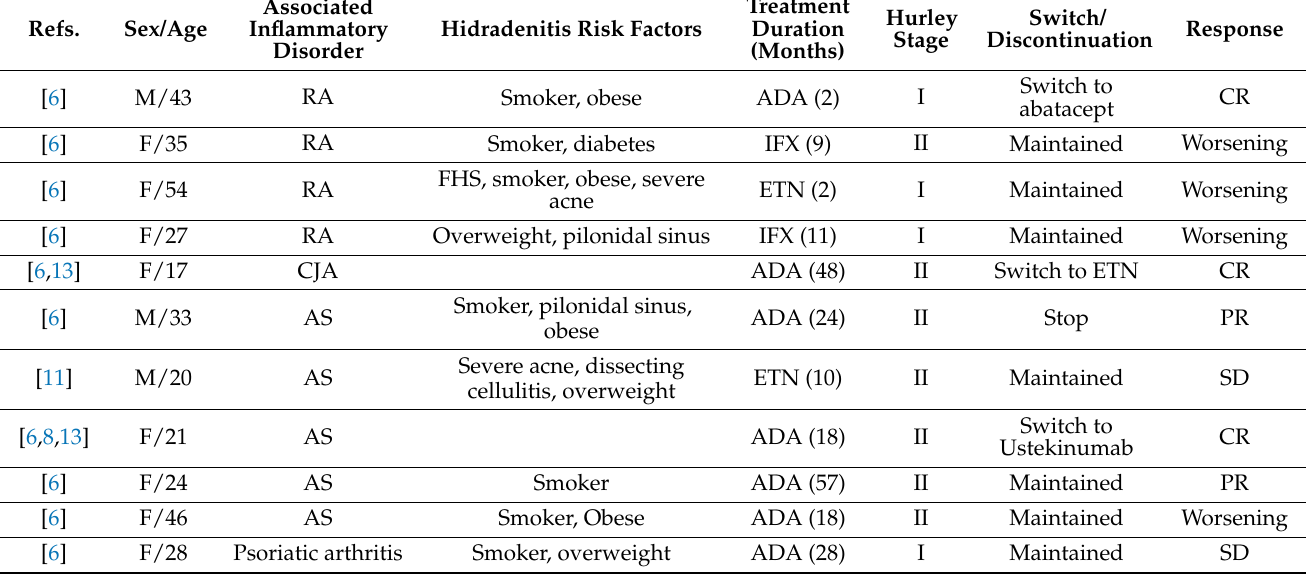
Table 1. Reported cases of paradoxical hidradenitis suppurativa in patients treated with biologic agents.